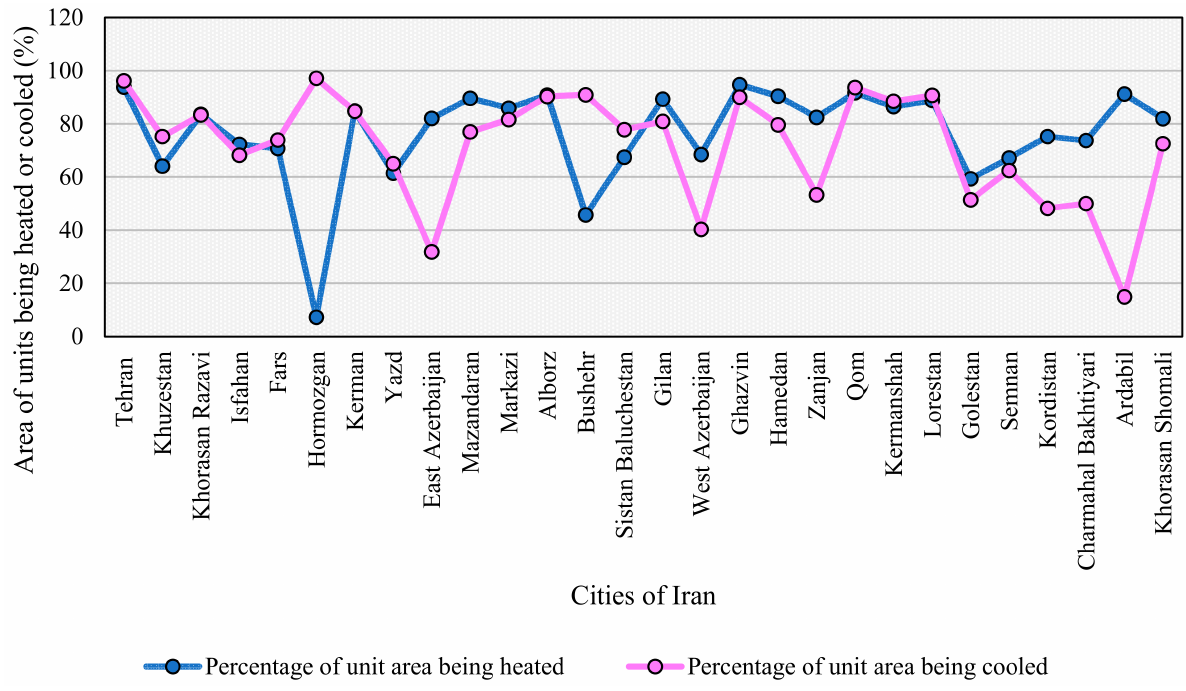
Figure 25. Percentage of units being heated or cooled in provinces of Iran.